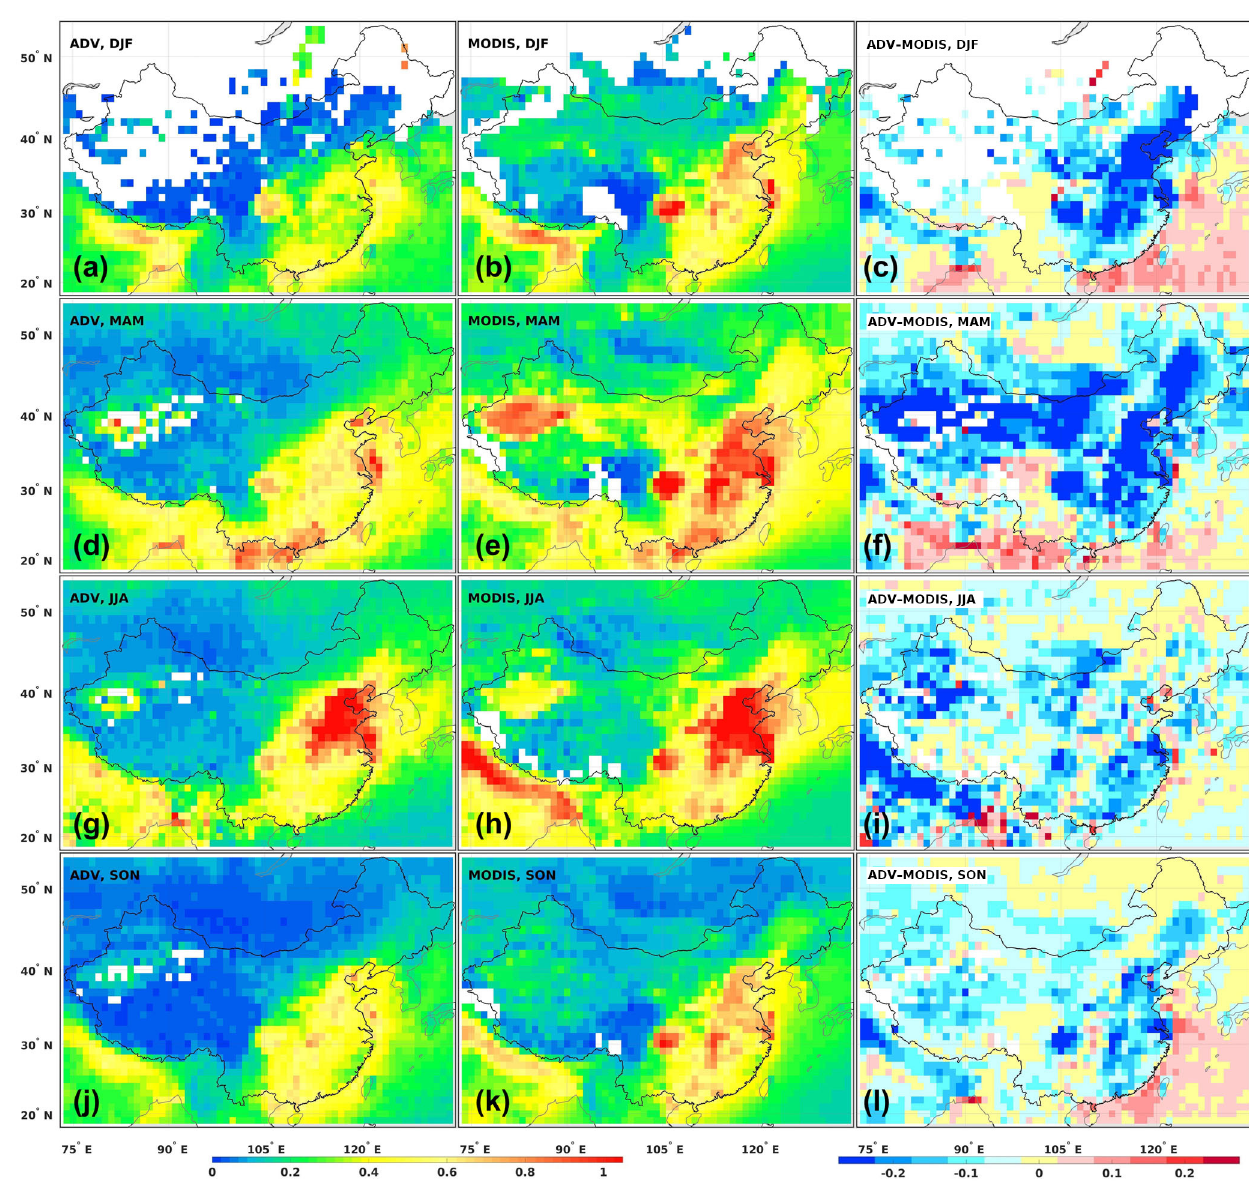
Figure 10. Seasonal AOD maps aggregated over the years 2000–2011 (top to bottom: DJF (winter), MAM (spring), JJA (summer) and SON (autumn)). (a, d, g, j) : ATSR ADV v2.31 (adapted from de Leeuw et al., 2018, Fig. 11); (b, e, h, k) : MODIS/Terra C6.1 merged DBDT; (c, f, i, l) : difference maps ADV–MODIS. The AOD and difference scales are plotted at the bottom. Pixels for which no value was retrieved are plotted in